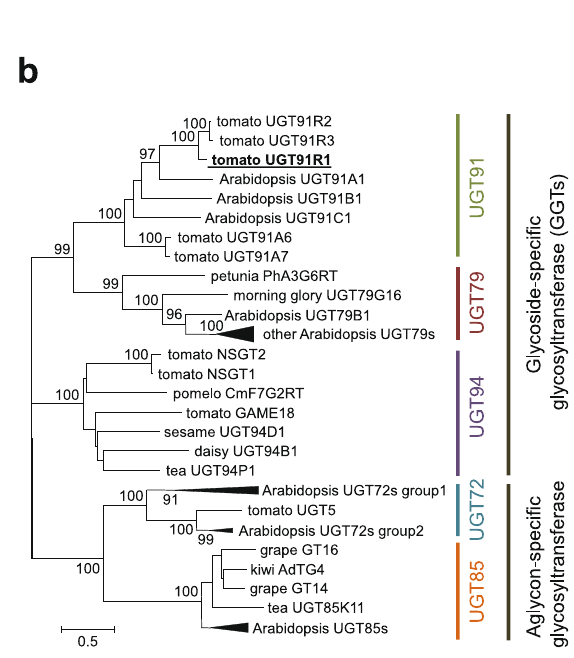
plants of S. lycopersicum and S. pennellii exposed to ( Z )-3-hexenol, respectively). Statistical signi fi cance among species and treatments were determined using the one-way ANOVA with the Tukey ’ s multiple comparison tests, and signi fi cant dif- ferences are indicated by different characters ( p <0.05). b HexVic content in the leaves of ( Z )-3-hexenol-exposed ILs. Errorbars indicate standarderror of the mean from three independent plants.